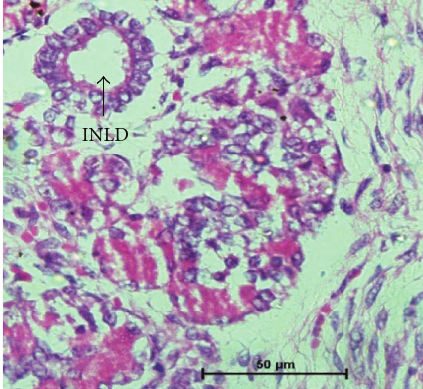
Figure 6: 19cm CVRL (114 days) showing interlobular duct (ILD) and well formed acini (A). Hematoxylin and eosin × 400.